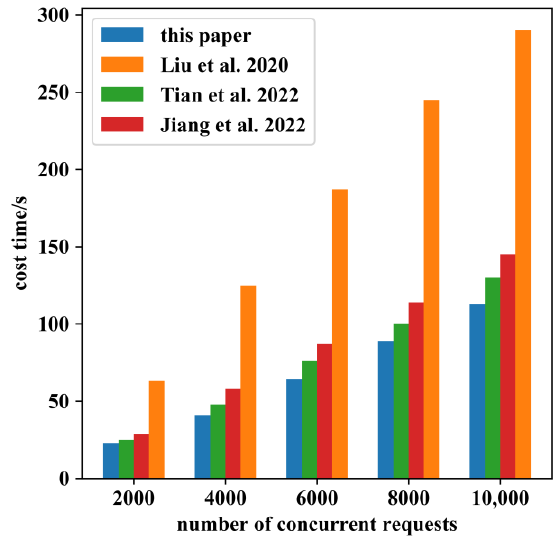
Figure 17. Time cost of access control process at different numbers of concurrent requests which compared with the results of the methods proposed by Liu [19], Tian [20], Jiang [21] respectively.